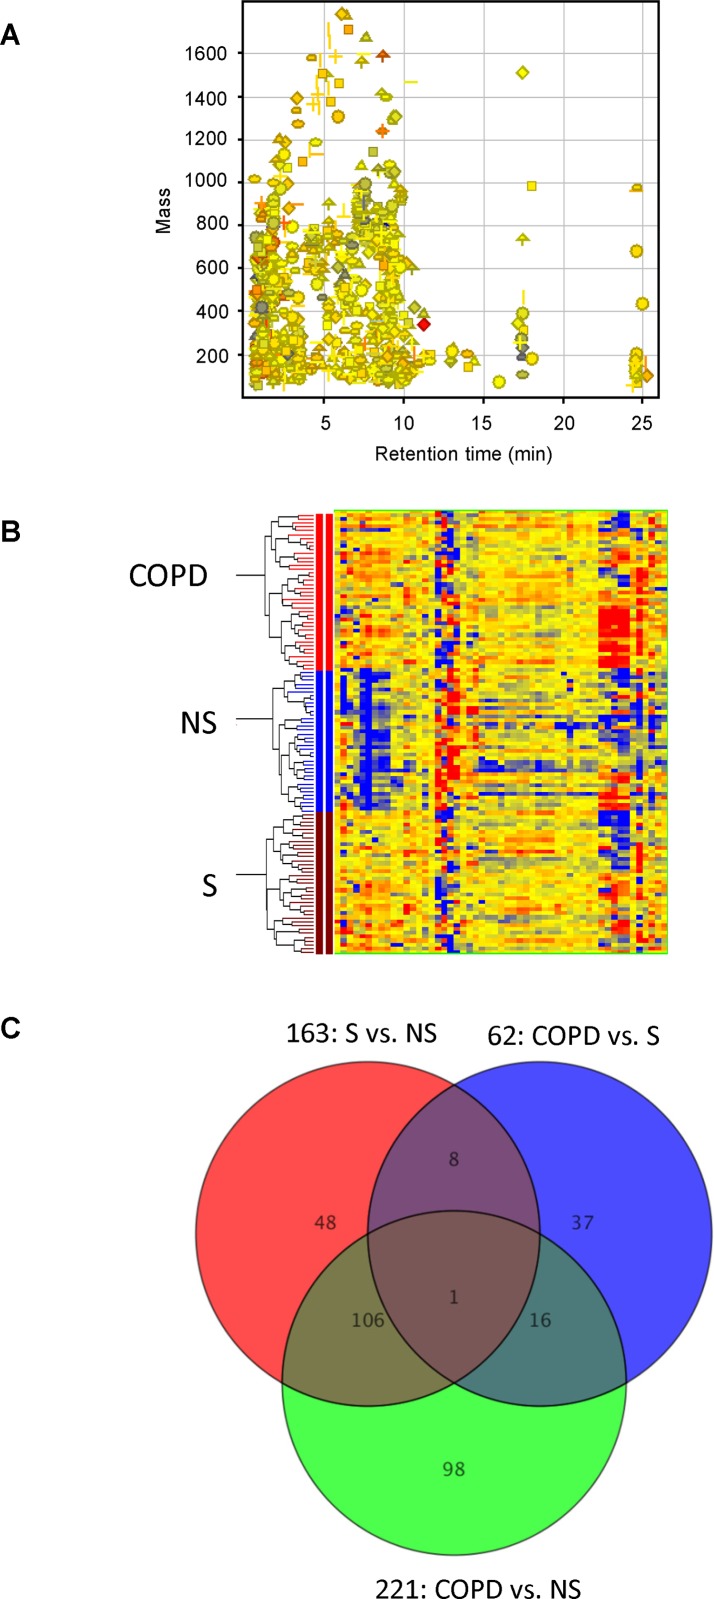
Untargeted metabolite profiling identifies differentially-expressed serum metabolites among COPD smokers, healthy smokers, and non-smokers (P<0.05).(A) A total of 1,181 aligned molecular features detected as positive and negative ions were quantified in all 115 serum samples by untargeted molecular feature extraction. (B) Heat map from hierarchical clustering analysis, showing 314 differentially-expressed metabolites among COPD smokers, healthy smokers and non-smokers. The relative level of expression of each metabolite is represented by a color coded heat map, where red represents an expression higher than the mean and blue represents an expression below the mean values. (C) Venn Diagram depicts shared metabolite changes among COPD smokers, healthy smokers and non-smokers (p < 0.05). Of these, 62 metabolites were significantly different (P<0.05) between healthy smokers and COPD smokers. And 17 of these 62 metabolites were differentially-expressed in COPD smokers compared to both healthy smokers and non-smokers, but showed no difference between healthy smokers and non-smokers.